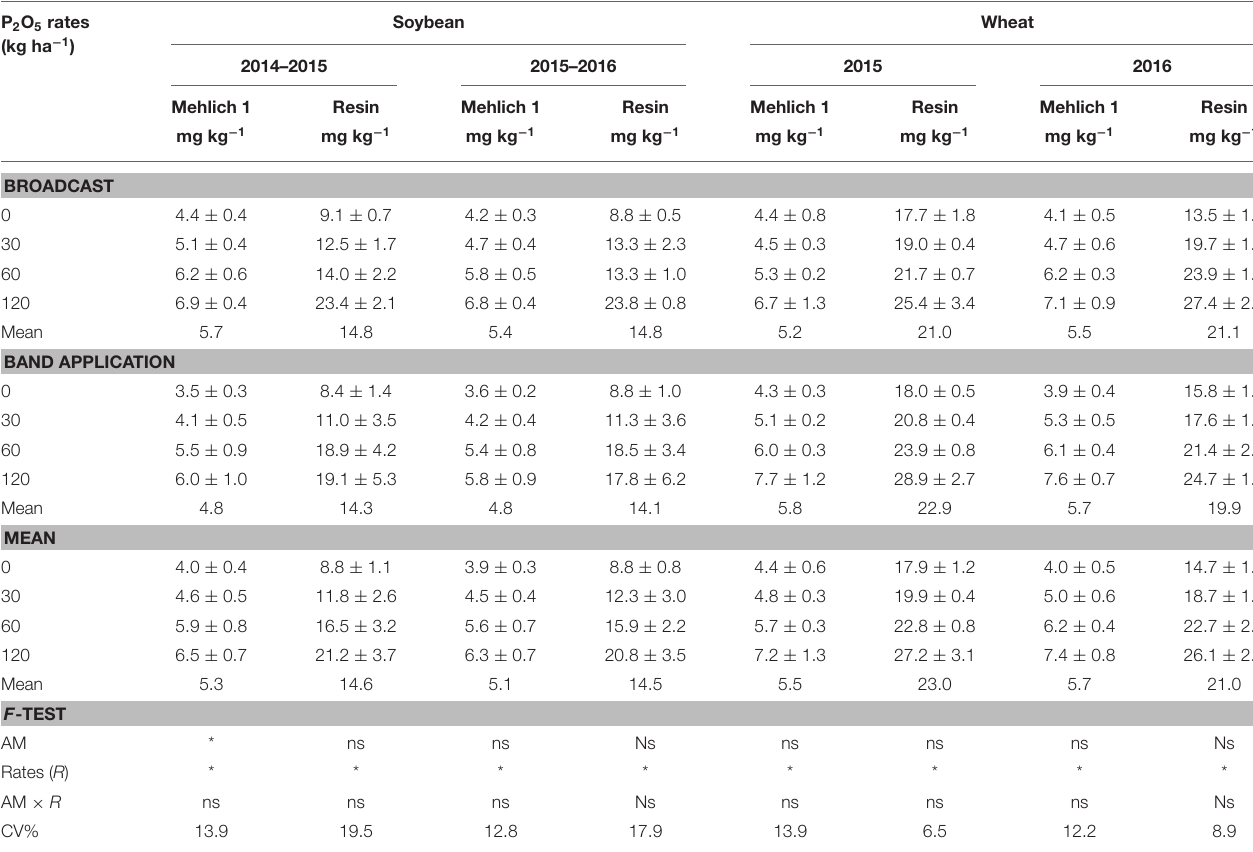
TABLE 2 | Phosphorus availability in the soil with Mehlich 1 and resin extractants after a soybean-wheat cropping system due to the P 2 O 5 rates and application method (AM) (broadcast and band application), Londrina, Paraná State, Brazil. P 2 O 5 rates (kg ha − 1